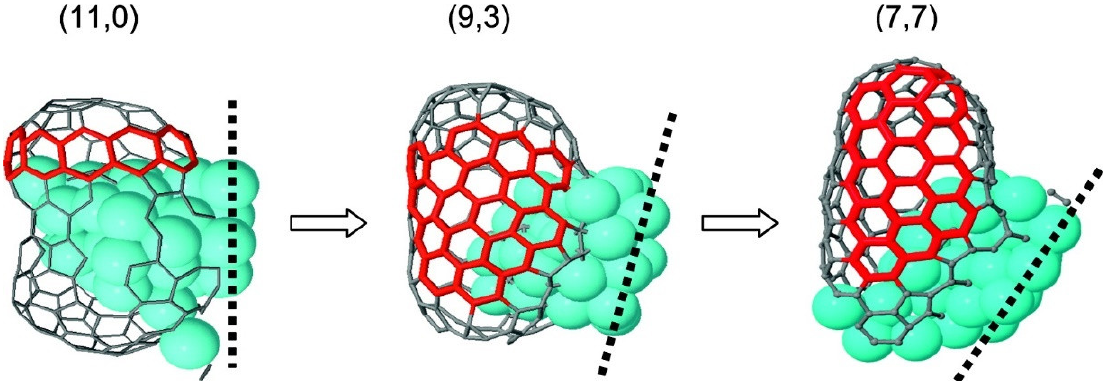
Figure 3. Chirality changes during the growth of carbon nanotube [75] . Copyright 2011, American Chemical Society.